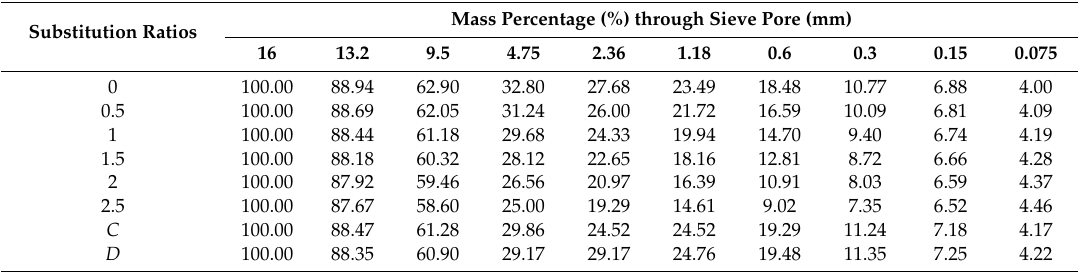
Table 13. Gradations of di ff erent substitution ratios.